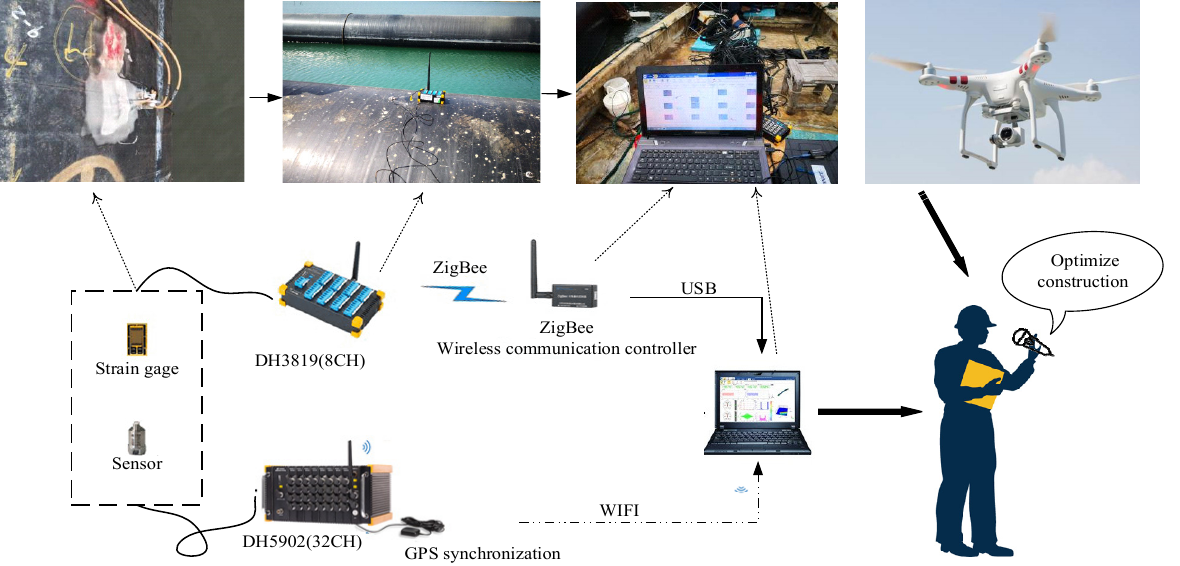
Figure 5. Flow chart of field monitoring data transmission.